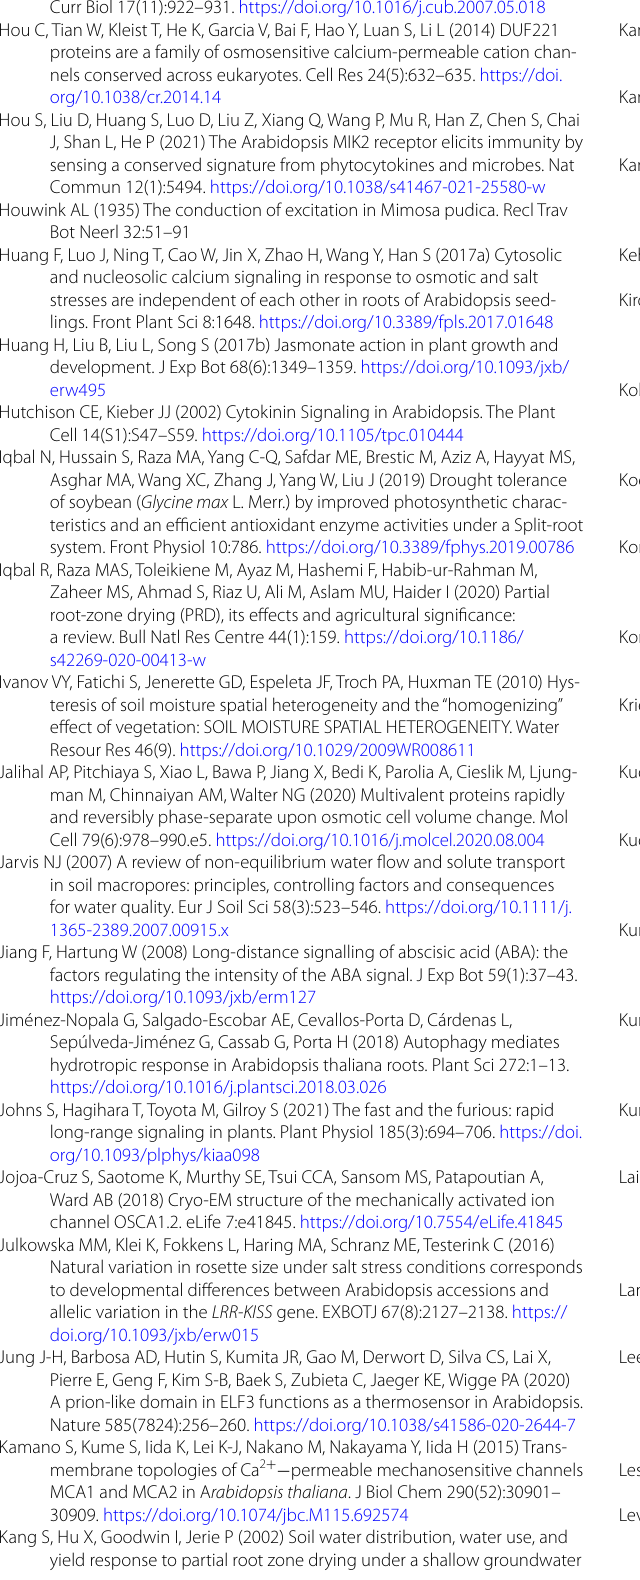
table condition in a pear orchard. Sci Hortic 92(3):277–291. https:// doi. org/ 10. 1016/ S0304- 4238(01)